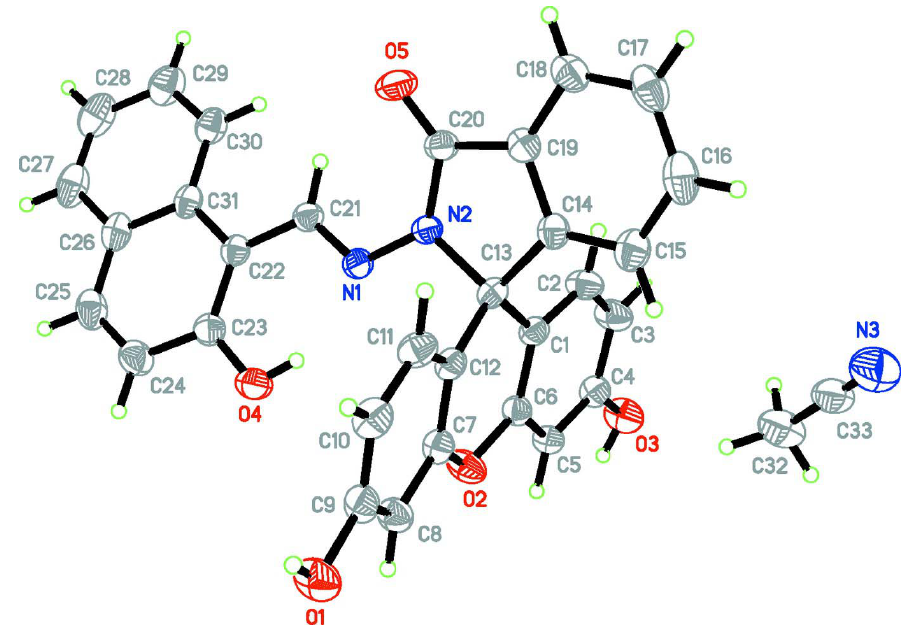
Figure 1 The asymmetric unit, with the atom-numbering scheme. Displacement ellipsoids are drawn at the 30% probability